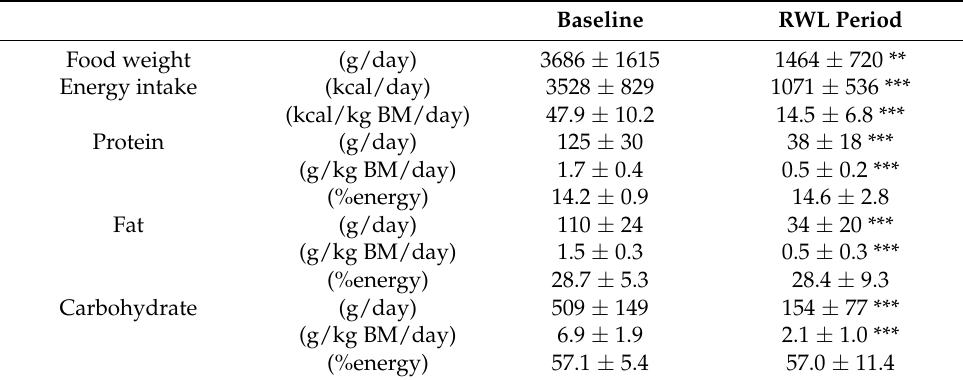
Table 3. Food weight, energy and macronutrient intake and energy expenditure.